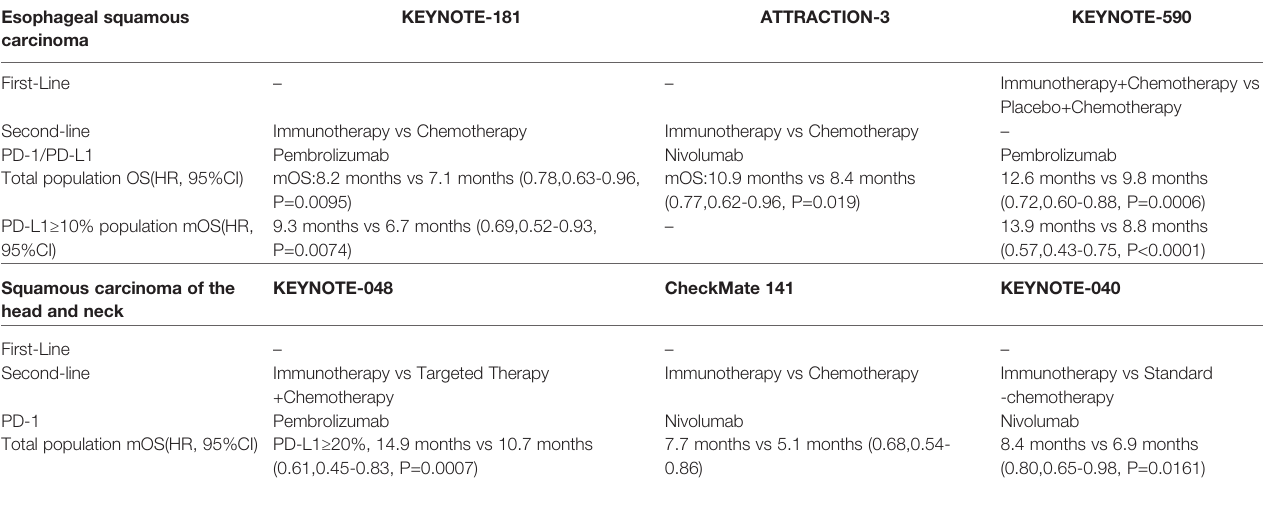
TABLE 1 | The latest treatment progress of esophageal squamous cell carcinoma and head and neck squamous cell carcinoma. Esophageal squamous KEYNOTE-181 ATTRACTION-3 carcinoma